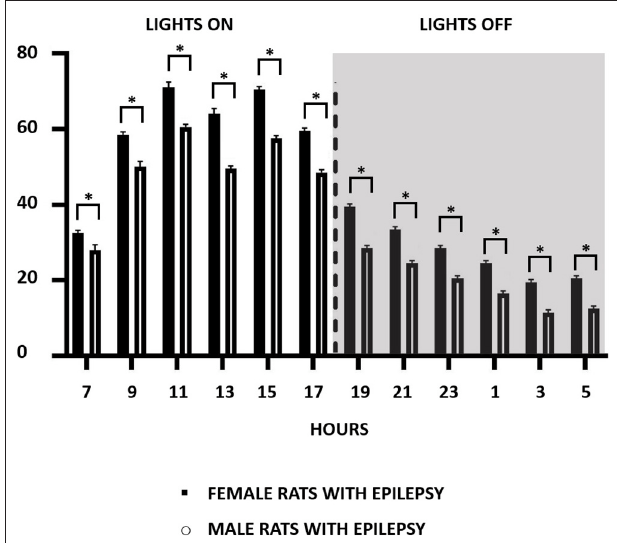
FIGURE 2 | Number of recurrent seizure distribution in a 2-h pattern for 24-h recordings over a period of 3 months during the light (07:00–18:59h) and dark (19:00–06:59h) cycle in both male and female epileptic rats. Data are expressed as mean ± SD. * p <